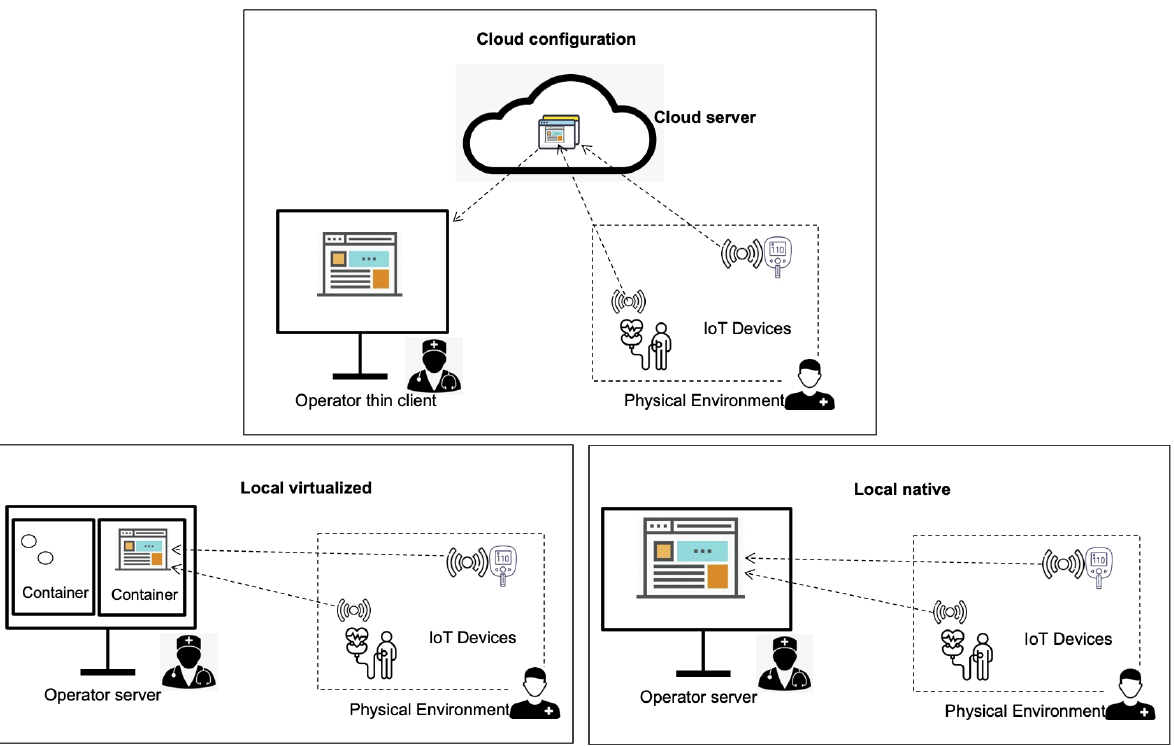
Figure 3. Architectural perspectives for IoT platform